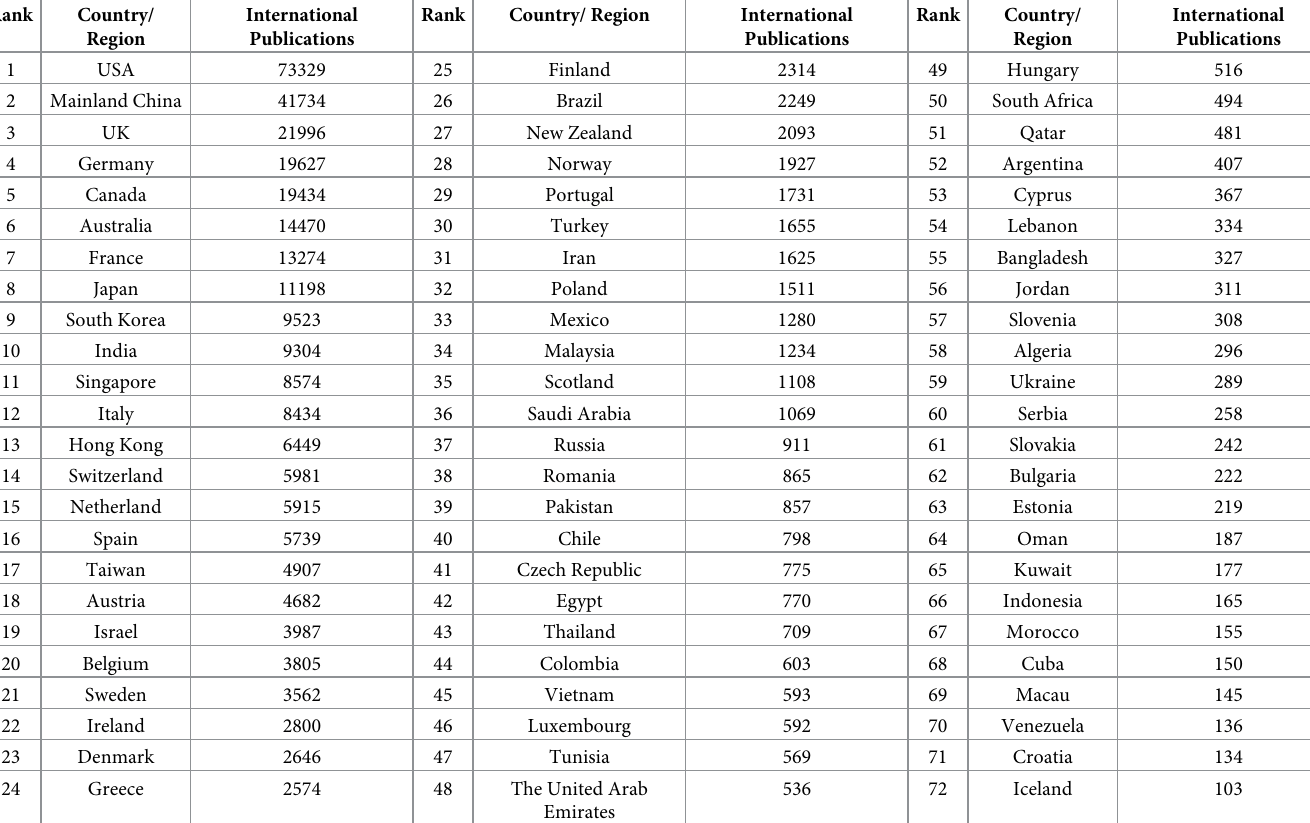
Table 1. Ranking of countries/regions in term of the number of international